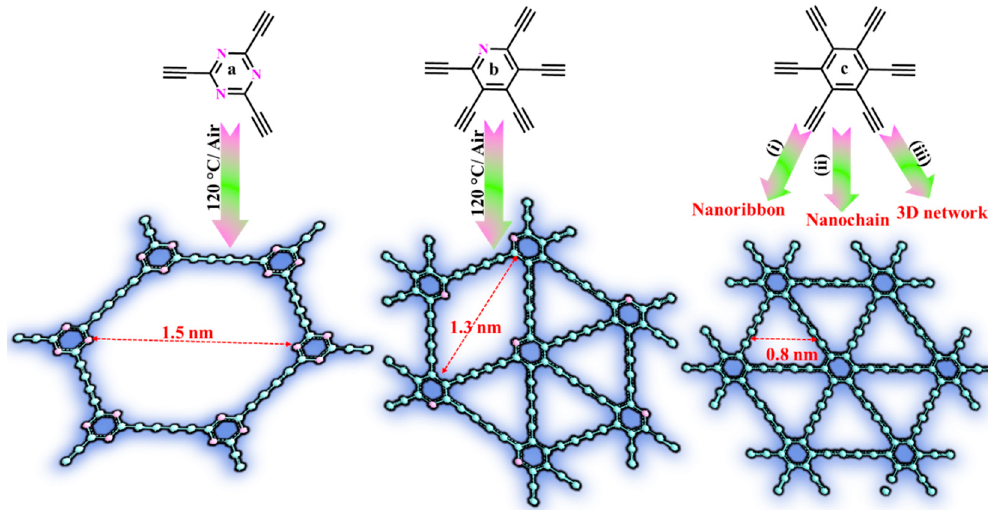
Figure 5. Thermal treatments of ( a ) TET, ( b ) PEP, and ( c ) HEB: (i) gradually heated to 120 °C/N 2 ; (ii) rapidly heated to 120 °C/Air; and (iii) gradually heated to 120 °C/Air. Redrawn [63,64].